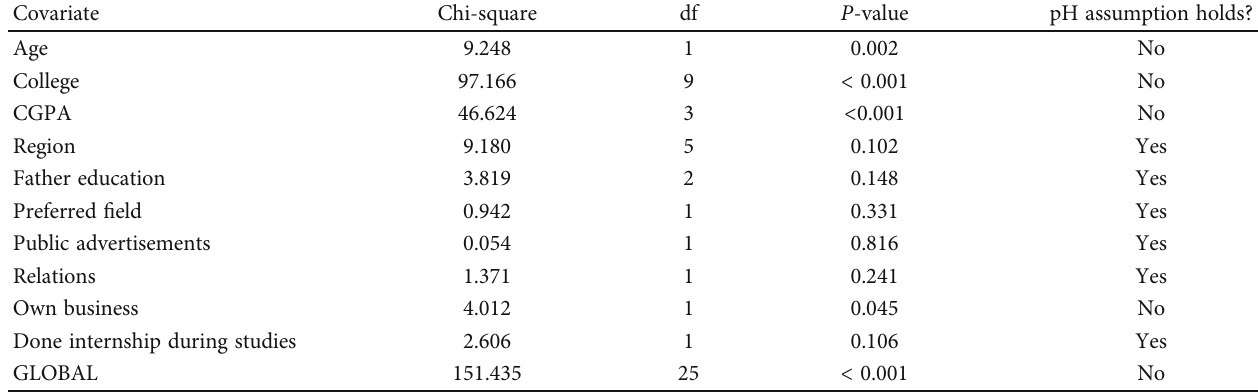
Table 3: The goodness of fi t test based on Schoenfeld residual for sample graduate 2019.